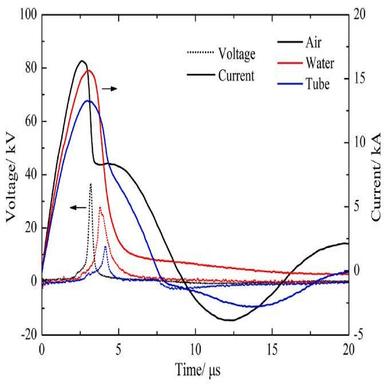
The electrical parameters of exploding a copper wire in different mediums at a stored energy of 500 J.